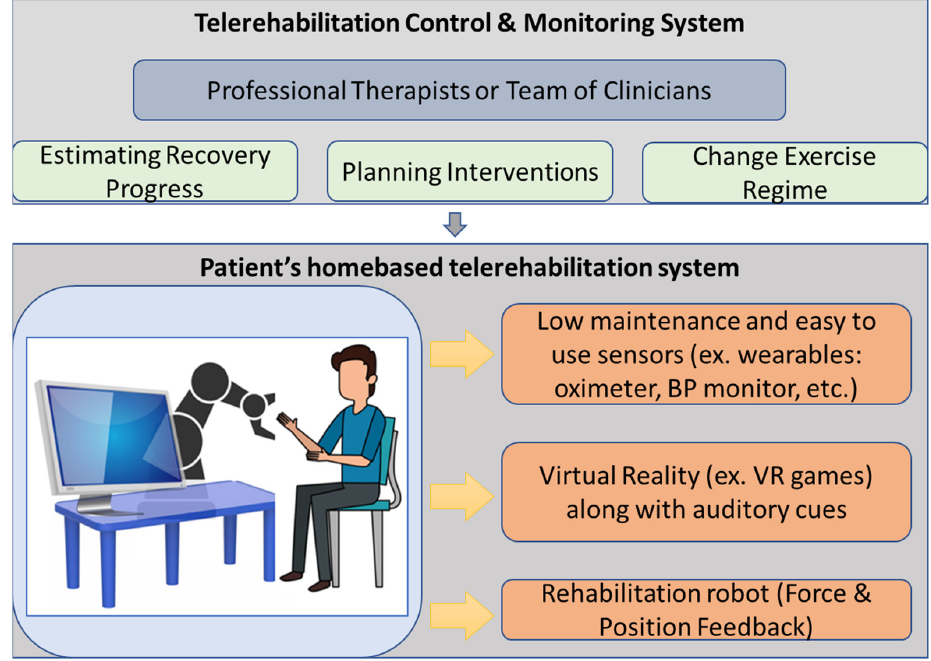
Figure 1. RoboTeleRehab system overview.